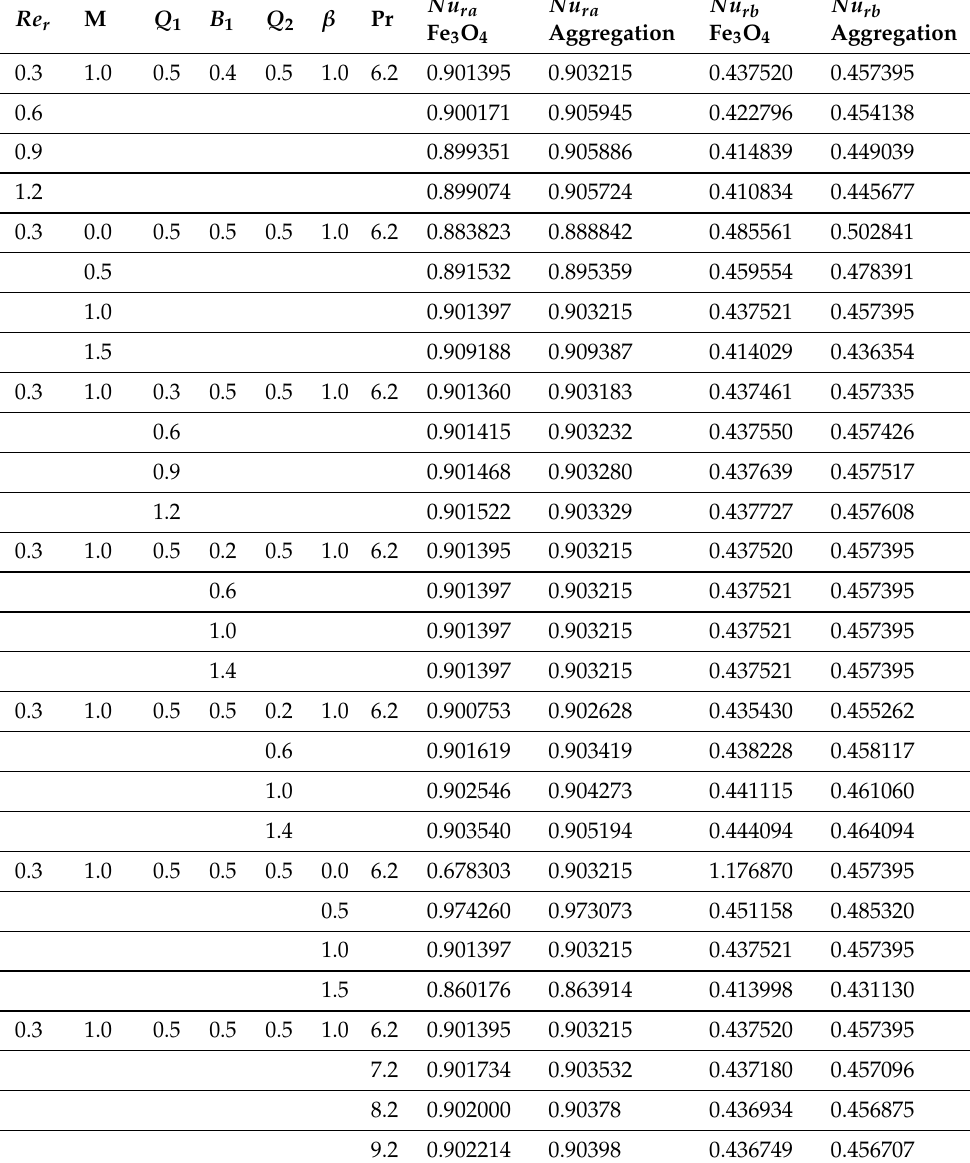
Table 5. Nusselt number for higher values Re r , Pr , B 1 and β